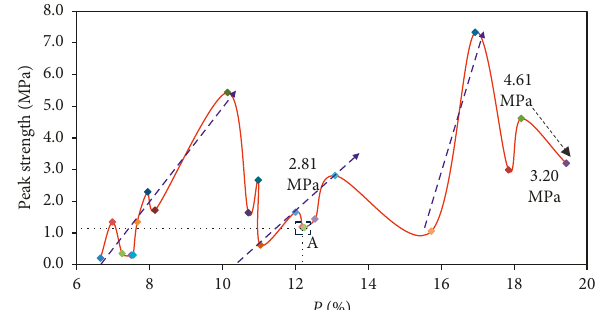
Figure 6: Relationship between test sample strength and calcium carbonate pore filling ratio under different control